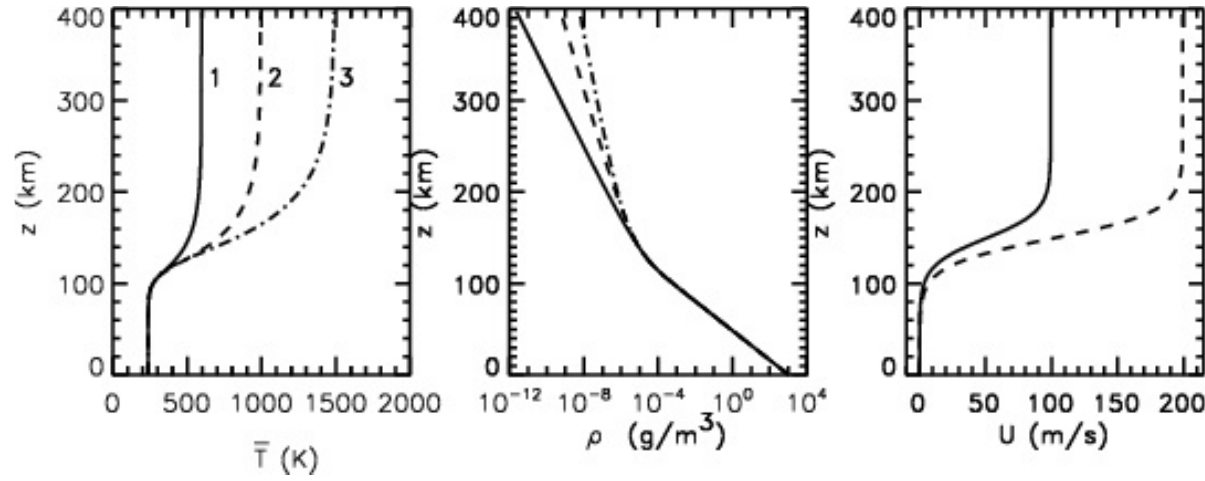
Fig. 1. Mean temperatures (left), densities (center), and zonal winds (right) assumed for the computations of GW propagation, dissipation, and momentum flux and divergence discussed in the text. Temperature profiles are assumed to be representative of solar minimum (solid), mean (dashed), and solar maximum (dotted) conditions with asymptotic thermospheric temperatures of 600, 1000, and 1500K (labeled 1, 2, and 3, respectively). Corresponding densities are shown on a semi-log plot (center). The zonal wind profiles represent nominal and extreme wind speed variations between assumed GW sources in the troposphere and the thermosphere; realistic (primarily tidal) wind variations in the MLT are not included, as only the velocity difference is important for GWs penetrating to high altitudes.